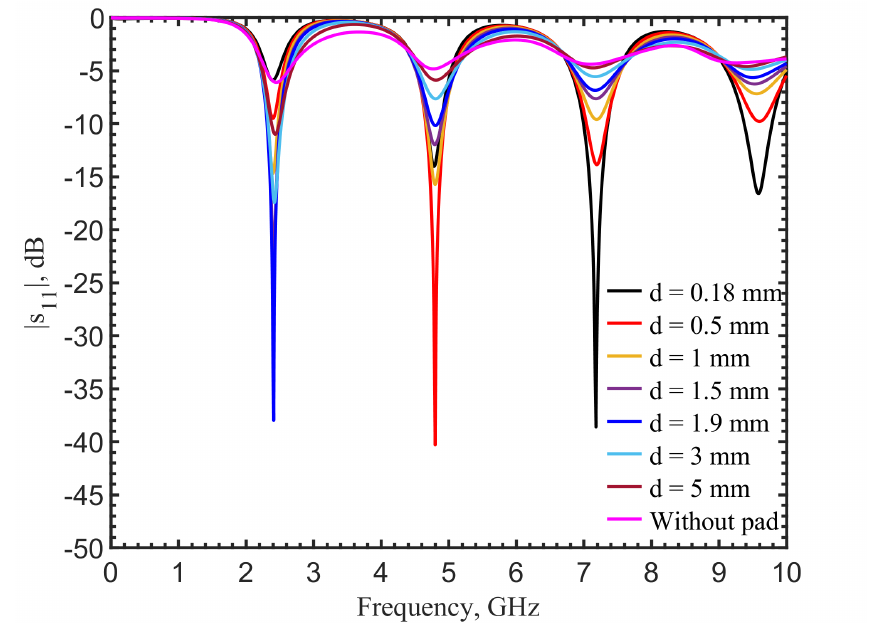
Figure 7. Comparison of simulations for tuned-loop resonators with different d